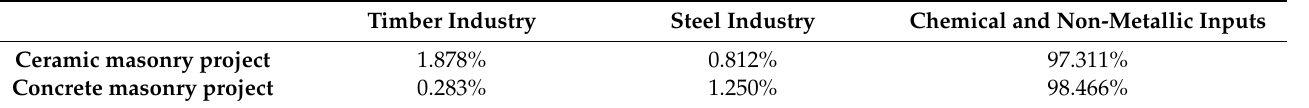
Table 5. Sector Equivalent Mass ( SEM )